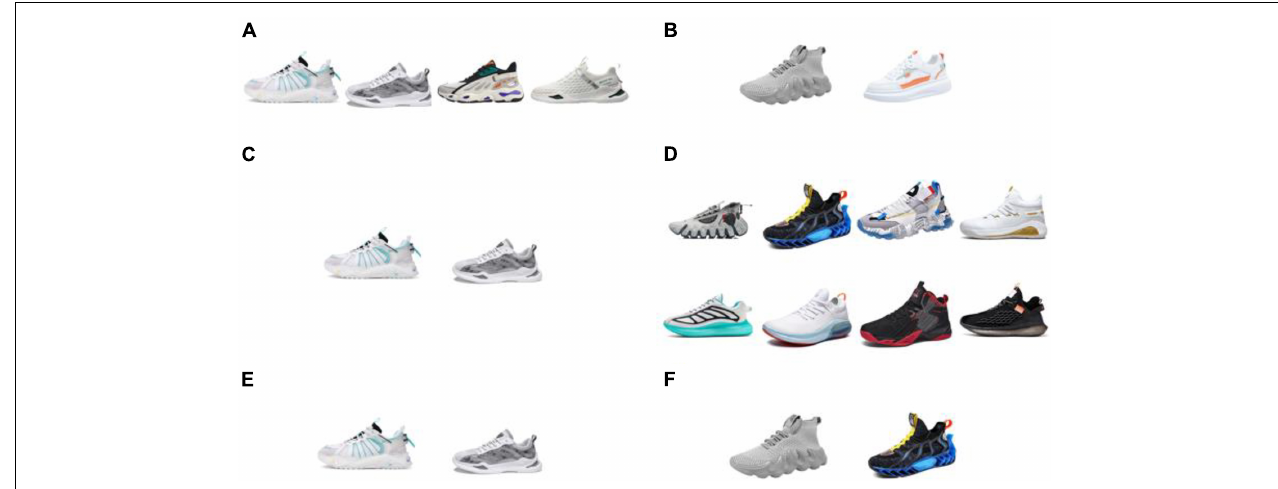
FIGURE 4 | Most liked and disliked shoes among different subject types (men, women, and all). Panel (A) are the most liked shoes among male subjects, panel (B) are the most disliked shoes among male subjects, panel (C) shows most liked shoes among female subjects, panel (D) shows most disliked shoes among female subjects, panel (E) are overall most liked shoes among all subjects, and panel (F) are overall most disliked shoes among all